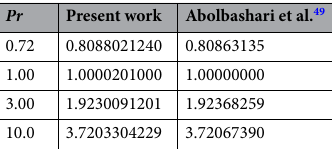
Table 3. Validation among present work and published by 49 in term of − ( Re ) − 1 / 2 Nu considering ϕ 1 , ϕ 2 , ϕ 3 , Ec , W , H t =